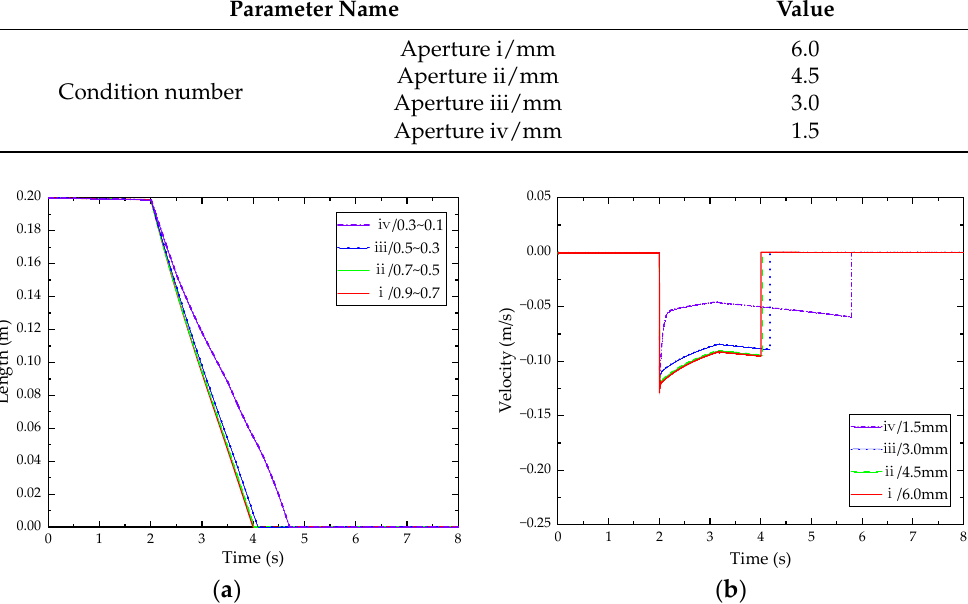
Table 7. Oil filter blockage under different working conditions.